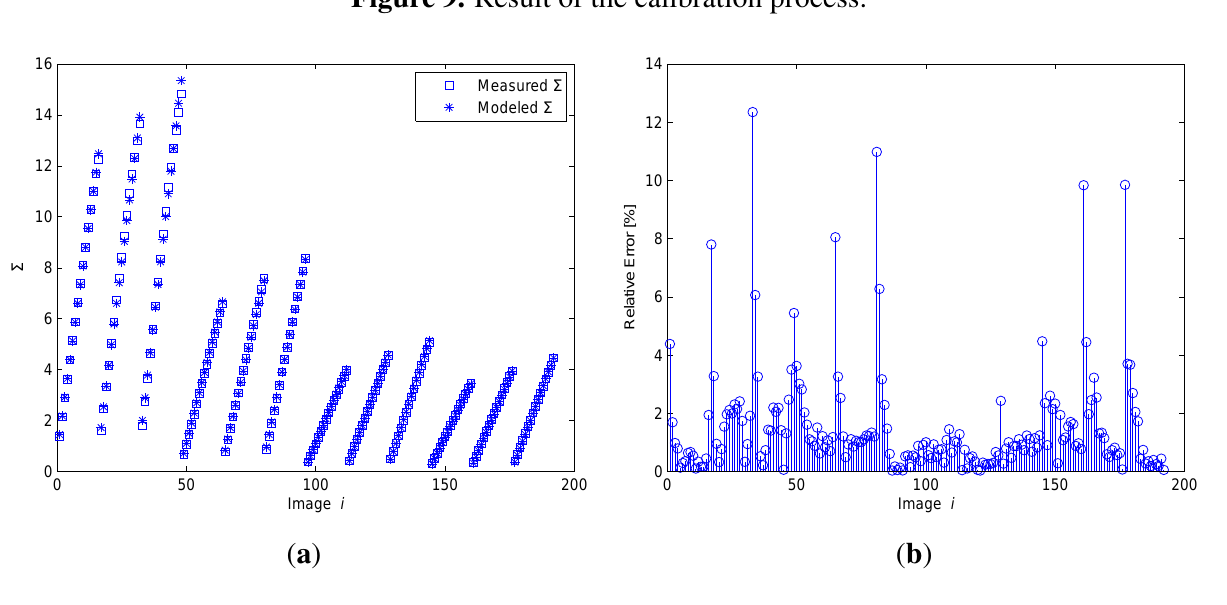
Figure 9. Result of the calibration